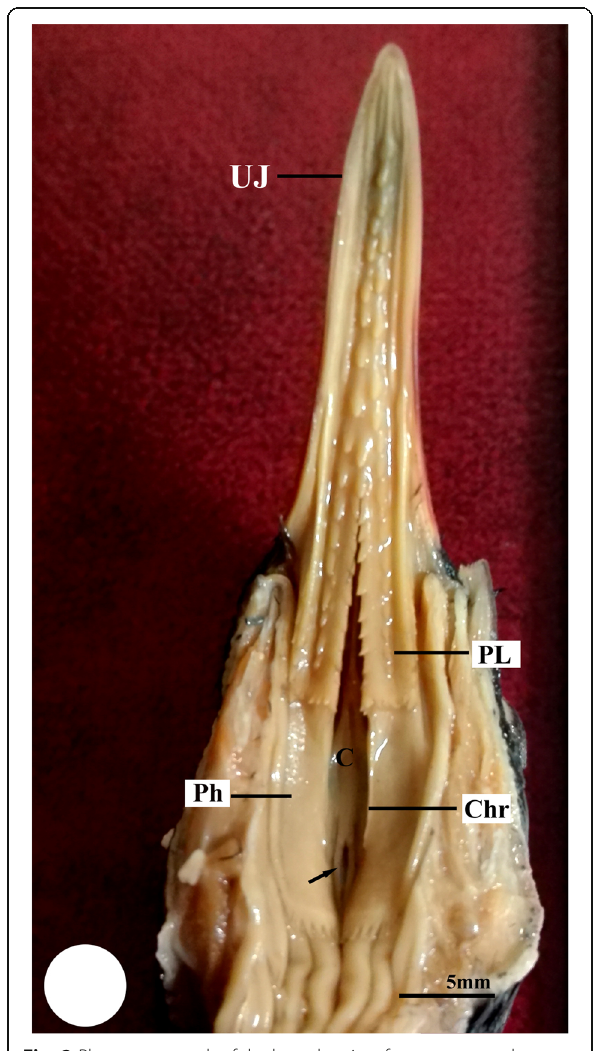
Fig. 1 Photomicrograph of the buccal cavity of kestrel shows palate region (PL), choana (C), pharyngeal region (Ph), infundibular fissure (IF), choana ridges (Chr), margins of infundibular fissure (arrow) with papillae, and tongue (T)